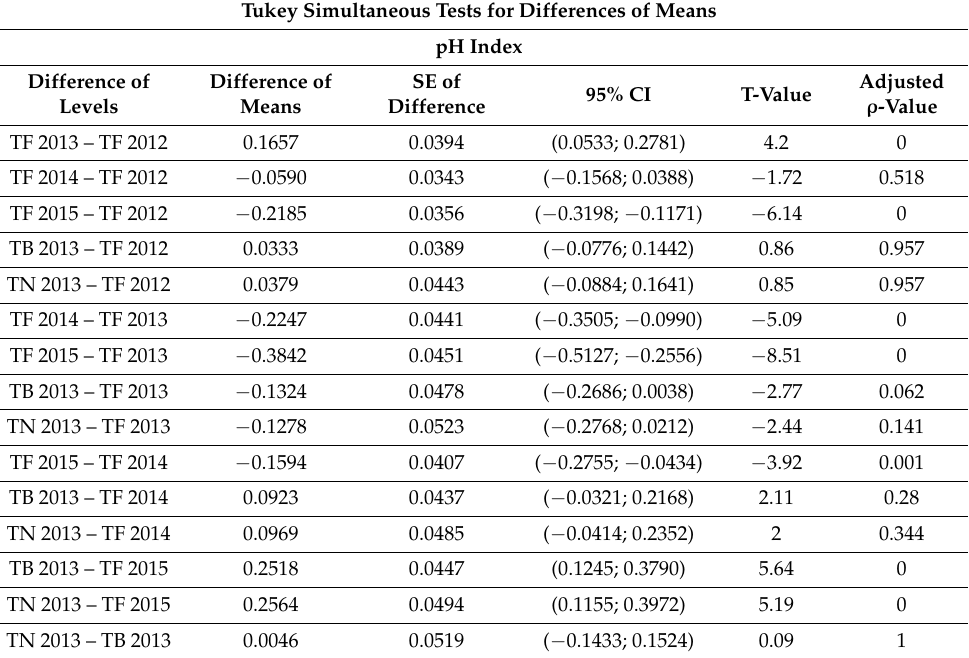
Table A5. One-way ANOVA for the pH index of the laboratory results.